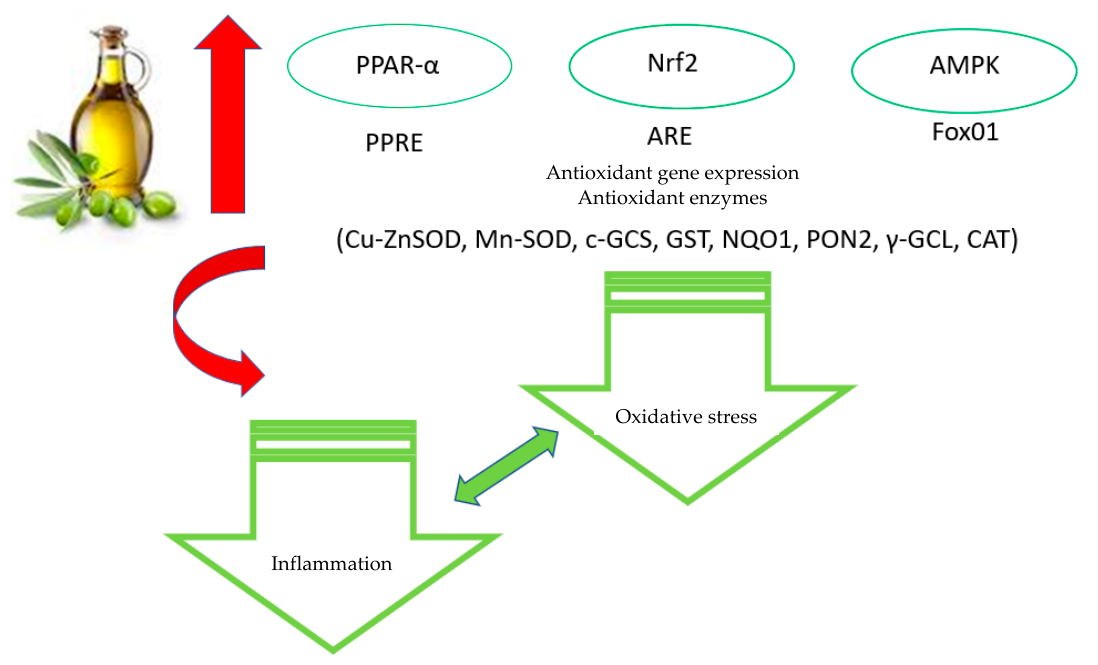
Figure 2. Main antioxidative effects of EVOO polyphenols.